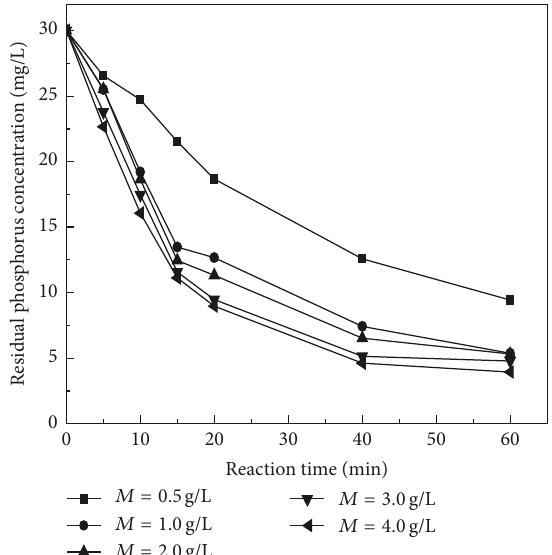
Figure 6: The effect of P-CSHs-PEG2000 dosage on phosphorus recovery system (initial concentration of phosphorus, 30 mg/L; initial pH, 7.0; stirring speed, 60 r/min).